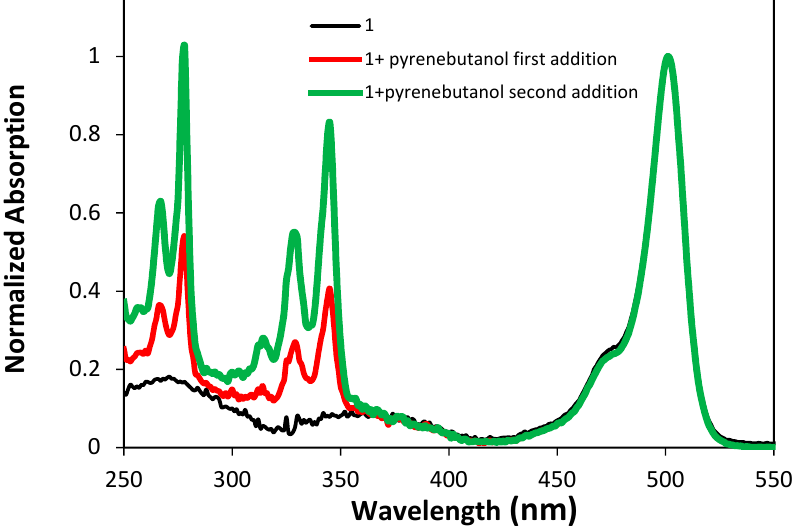
Figure 1. Absorption spectra for the compound 1 (1.2 × 10 − 5 M), a mixture of 1 (1.2 × 10 − 5 M) and 1-pyrenebutanol at 1.2 × 10 − 5 M and 2.4 × 10 − 5 M.